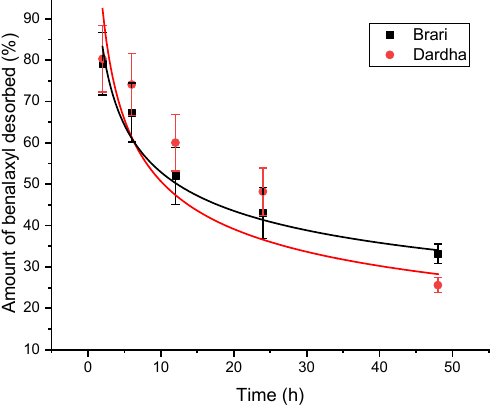
Figure 5. Desorbed amounts (%) of benalaxyl (25 mg/L) from Brari and Dardha clays. Figure 6 graphically shows the desorption process of dimethoate and methomyl from natural Brari clay. The curves show that methomyl desorbed much faster than dimethoate from Brari clay. At the same time, the desorbed amount (in %) of methomyl was twice the amount of dimethoate desorbed from Brari clay under strictly the same conditions.